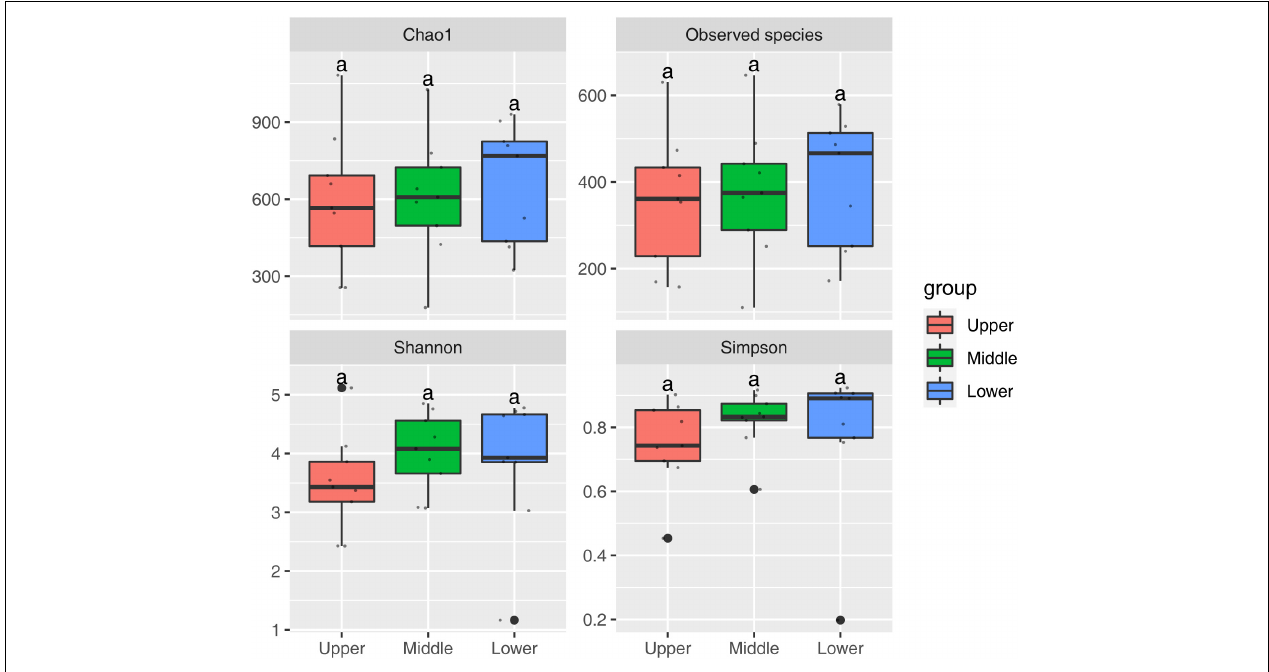
FIGURE 2 | Four α -diversity indexes of PM samples at different